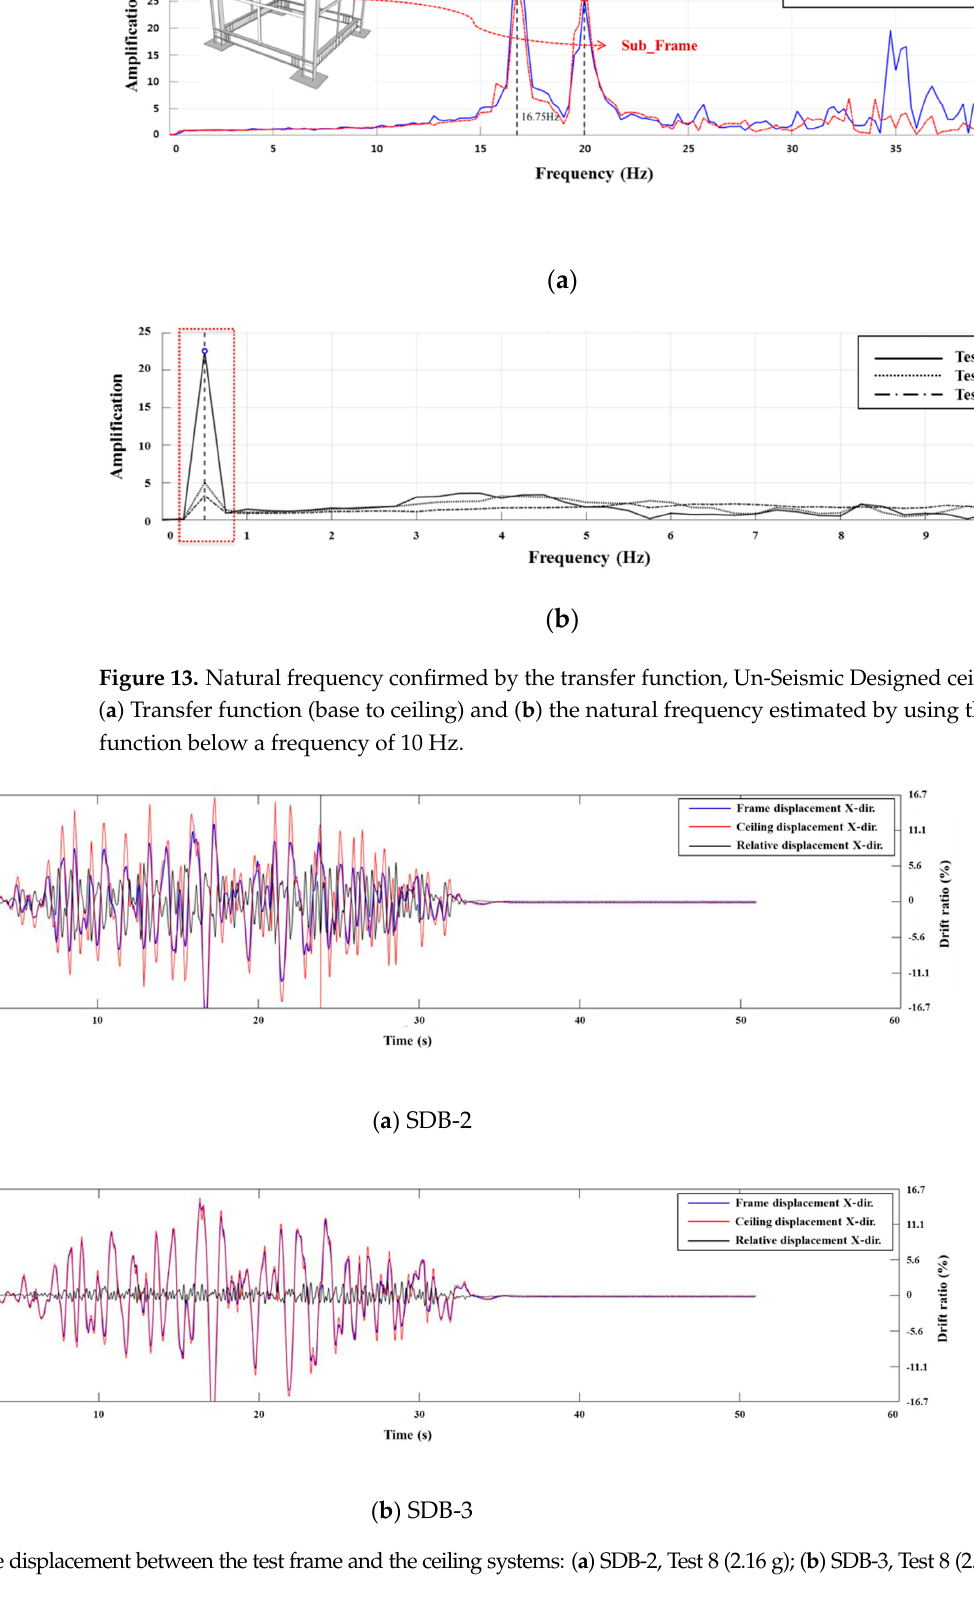
( b ) SDB-3 Figure 15. Maximum ceiling displacement of each specimen: ( a ) location of the maximum displacement of SDB-2, and ( b ) the location of the maximum displacement of SDB-3. In the final stage, the maximum relative displacement of SDB-2 was 59.67 mm, and for SDB-3 it was 19.83 mm. As demonstrated from the graph, it was confirmed that SDB-3 shows more integrated behavior with the test frame than the SDB-2 specimen. Because of this characteristic, the panel falling rate was low. The panel falling rates are listed in Table 5. The causes of the panel loss for the ceiling system can be divided into (1) a panel loss due to the occurrence of the impact load at the end, and (2) the panel loss